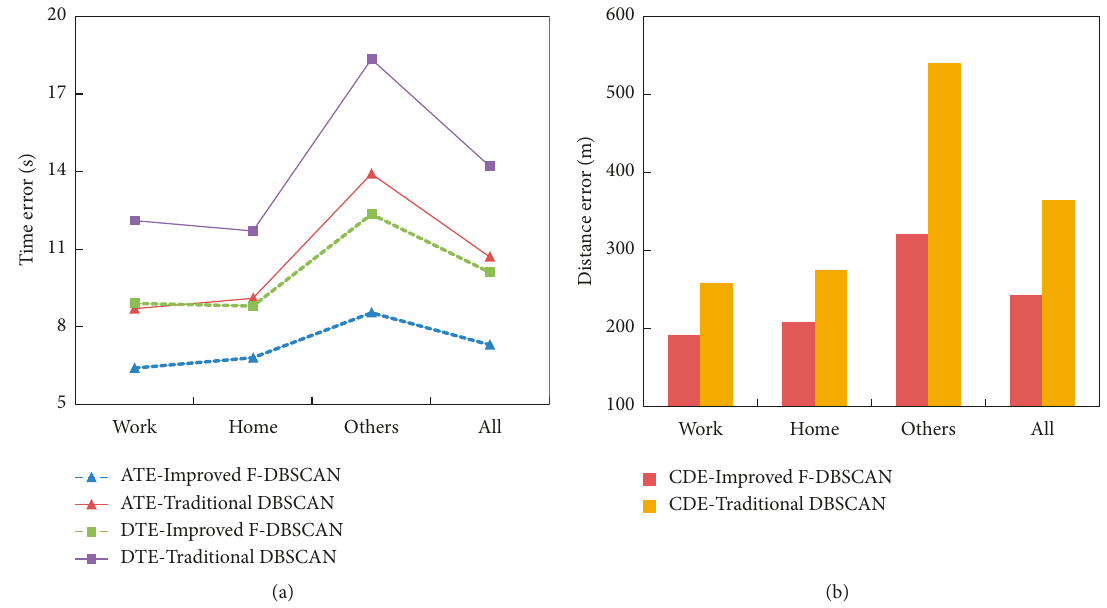
Figure 17: Identification errors of different types of trip ends. (a) ATE/DTE (unit: min). (b) CDE (unit: